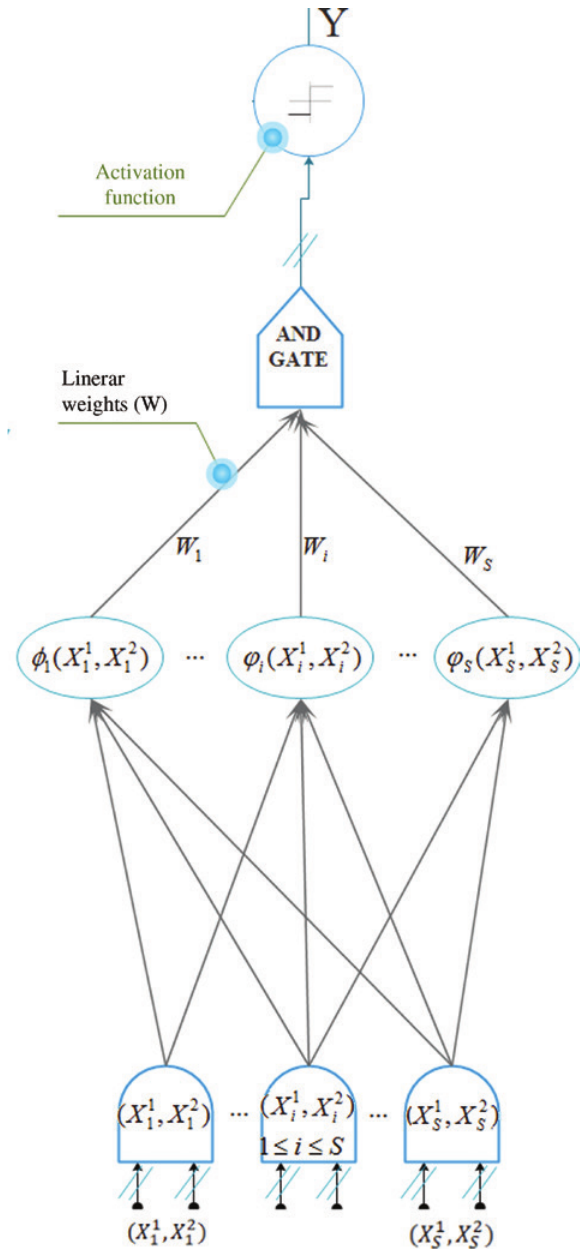
Figure 2: Structure of the RBF Neural Network Used in the ACT/R-RBF Hybrid